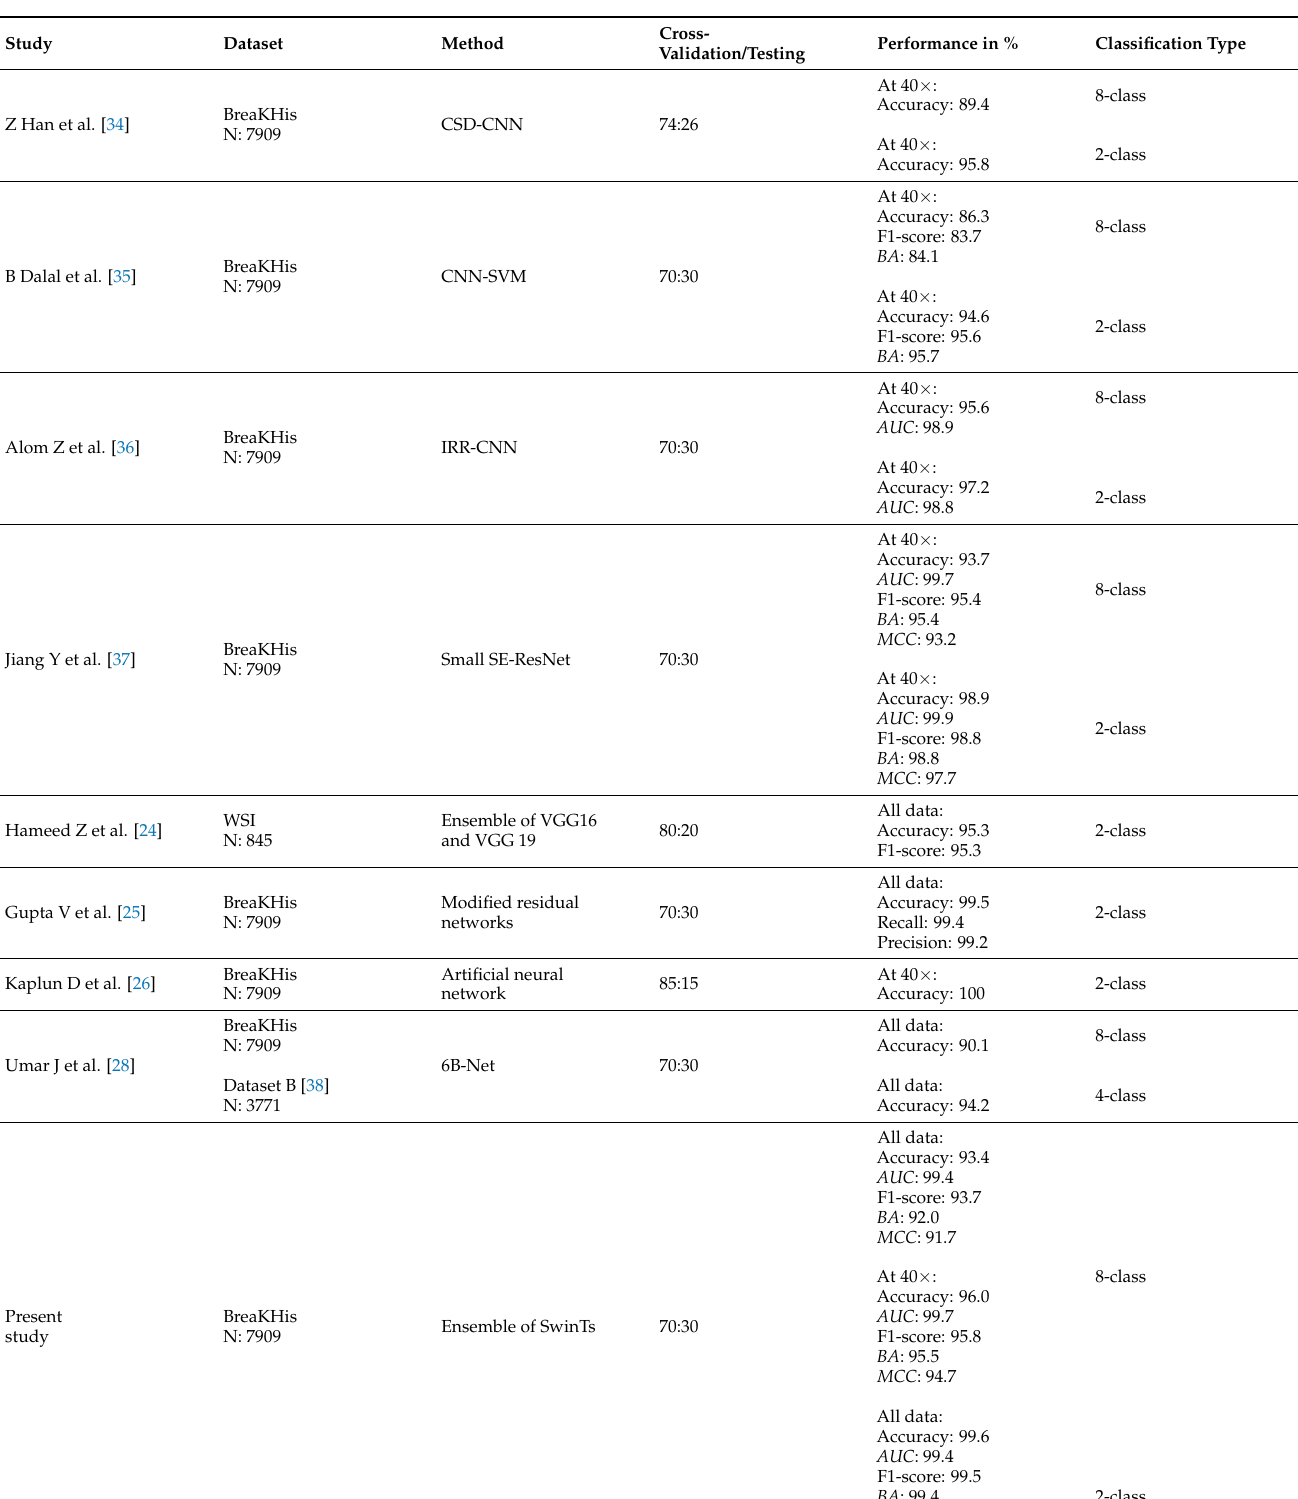
Table 4. Comparison of the present study with previous studies using histopathology images. AUC : area under the receiver operating characteristic curve, BA : balanced accuracy, MCC : Matthew’s correlation coefficient, N: number of images, SE: squeeze and excitation, WSI: whole slide image, IRR: inception recurrent residual, SVM: support vector machine, SwinT: swin